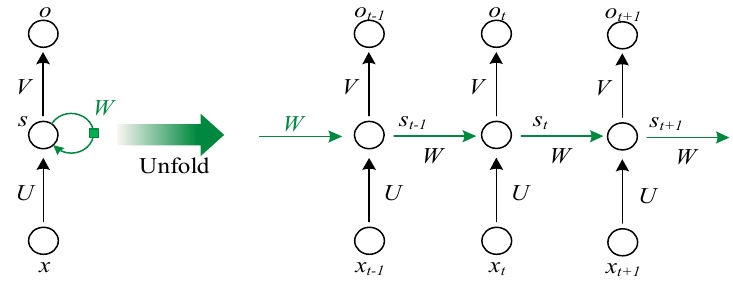
Figure 1. Unfold of RNN (Recurrent Neural Network).